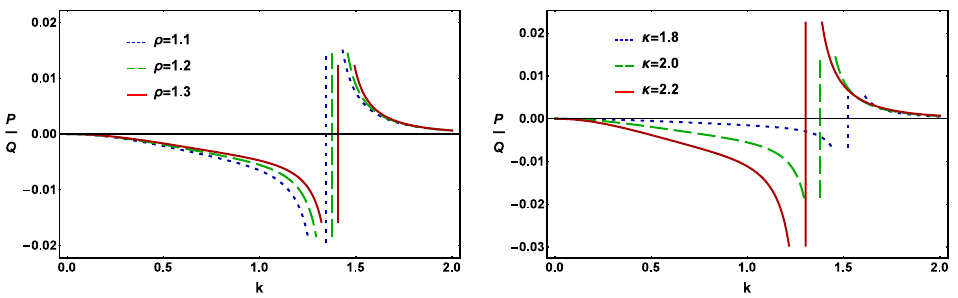
Figure 3. Plot of P / Q vs. k for the change of ρ (left panel) and κ (right panel) when η = 0.07, (cid:36) = 1.5, µ 1 = 0.7, and µ 2 =